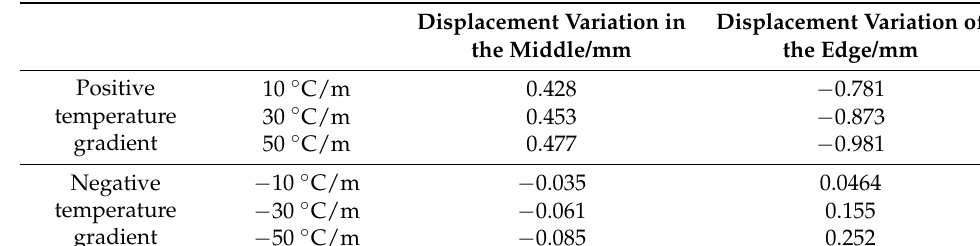
Table 5. Displacement changes in the middle and edge of the slab track under positive and negative temperature gradients.